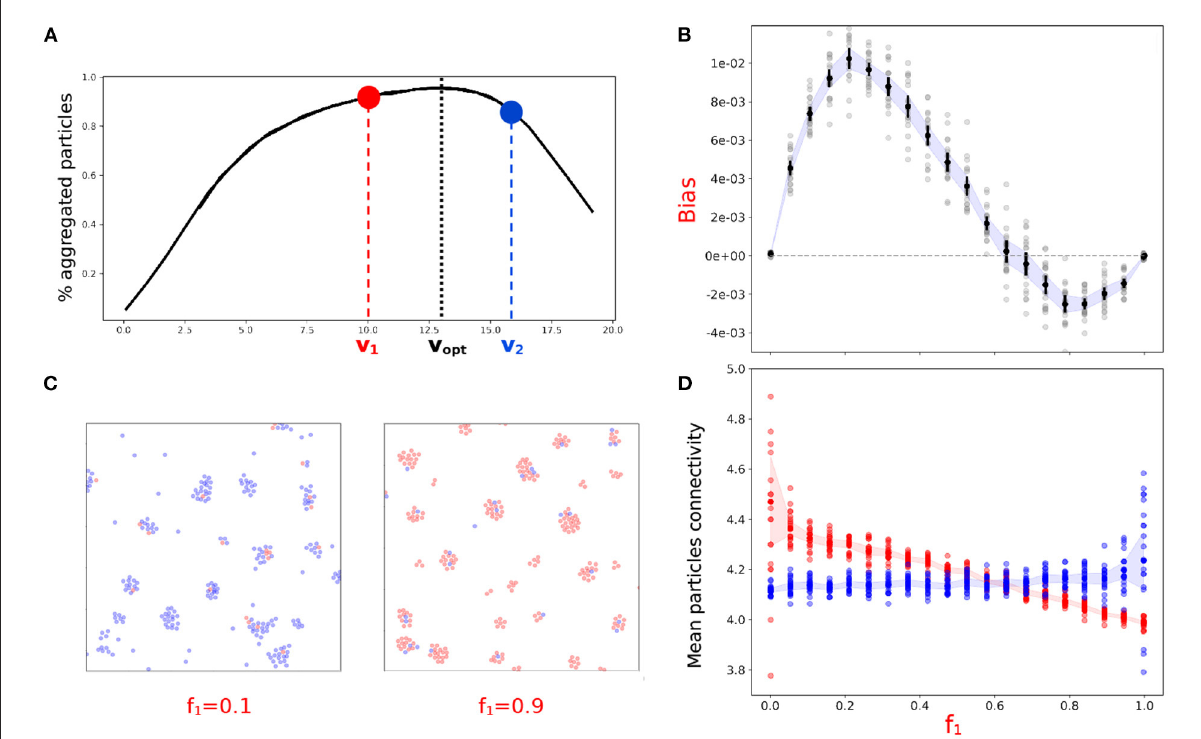
FIGURE5 Heterogeneity in particle speed induces biases whose sign depends on composition of the binary mix. (A) Binary mix of particles with speed on both sides of v opt . (B) Aggregation bias of the slower population when mixed in different proportion ( f 1 ) with the faster population. (C) Zoom on snapshots of the final state of the system for f 1 0.1 and f 1 0.9. (D) Mean connectivity of the two types of aggregated particles as a function = = of f 1 . (B,D) Twenty independent simulations were run were for each f 1 -value. The shaded area represents the 95 % confidence interval.